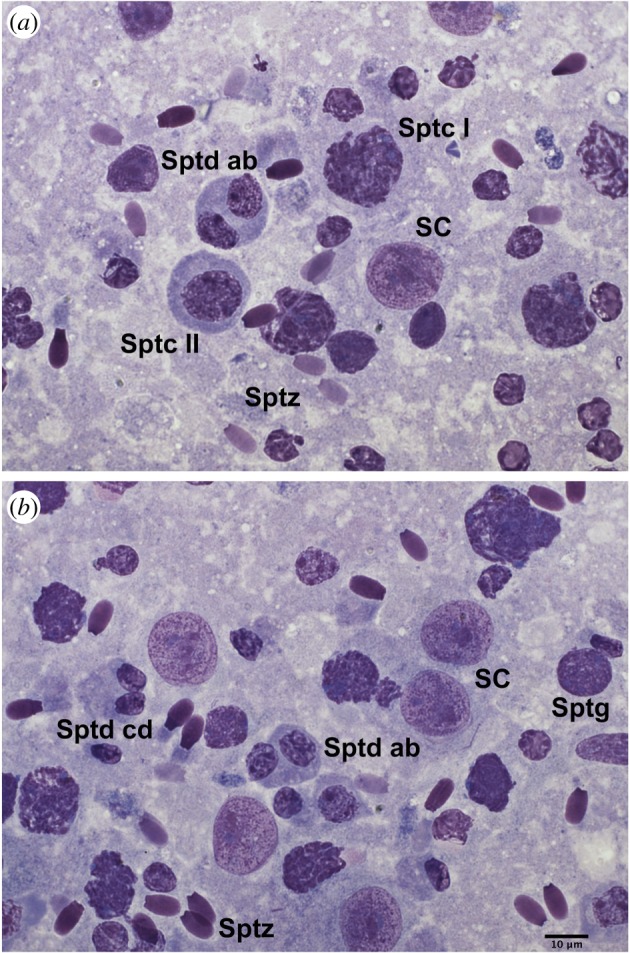
Testicular germ cells and Sertoli cells from fallow deer yearlings. (a,b) SC, Sertoli cell; Sptg, spermatogonium; Sptc I, primary spermatocyte; Sptc II, secondary spermatocyte; Sptd ab, round spermatid; Sptd cd, elongated spermatid; Sptz, spermatozoon.